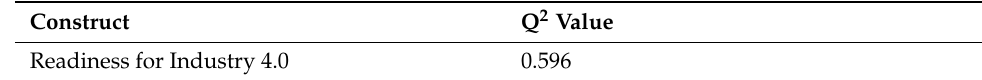
Table 15. Predictive relevance Q 2 .